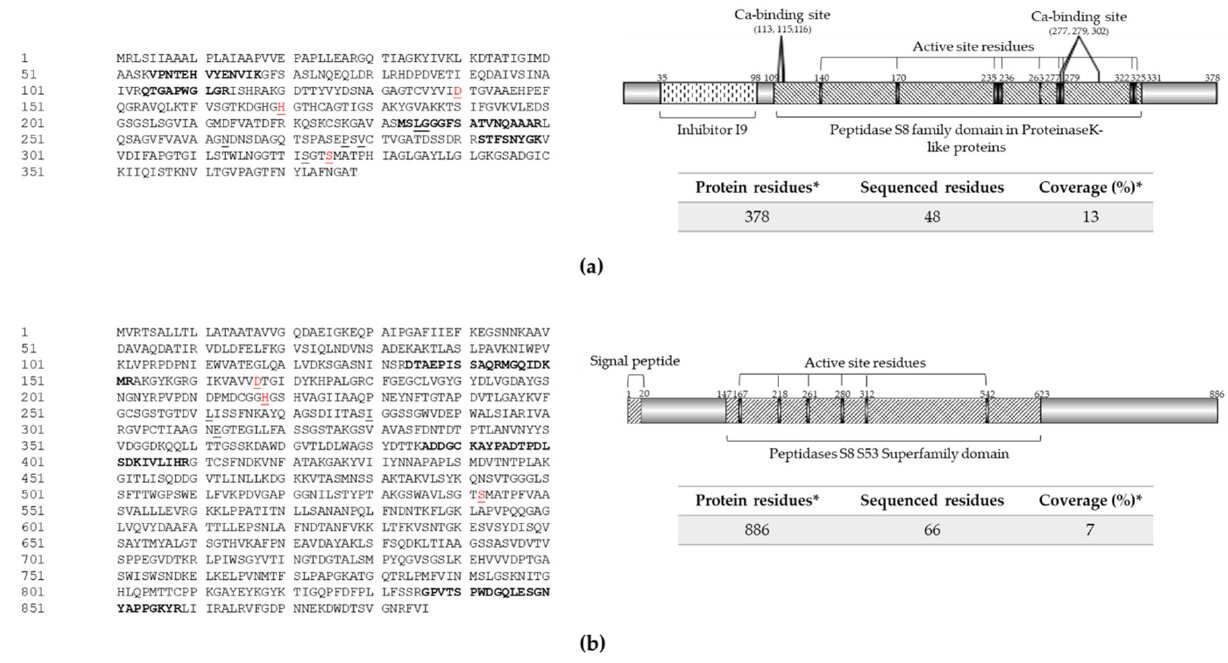
Figure 2. Extracellular proteases identified in protein extract from strain RGM 2184 culture super- natant in M2 medium. ( a , b ) Sequences and scheme of exoproteases P1 (OP328424) and P2 (OP328429), respectively. Exoprotease sequences (left panel) were predicted from the B. pseudobassiana RGM 2184 genome (JAKJXD000000000.1). Peptides sequenced by mass spectrometry are highlighted in bold in the left panel. Relevant domains for these proteins (right panels) were detected though the NCBI conserved domains database. Signal peptide (italic), active site residues (underlined), and catalytic triad (red) are indicated in the left and right panels, respectively. * indicates predicted information.